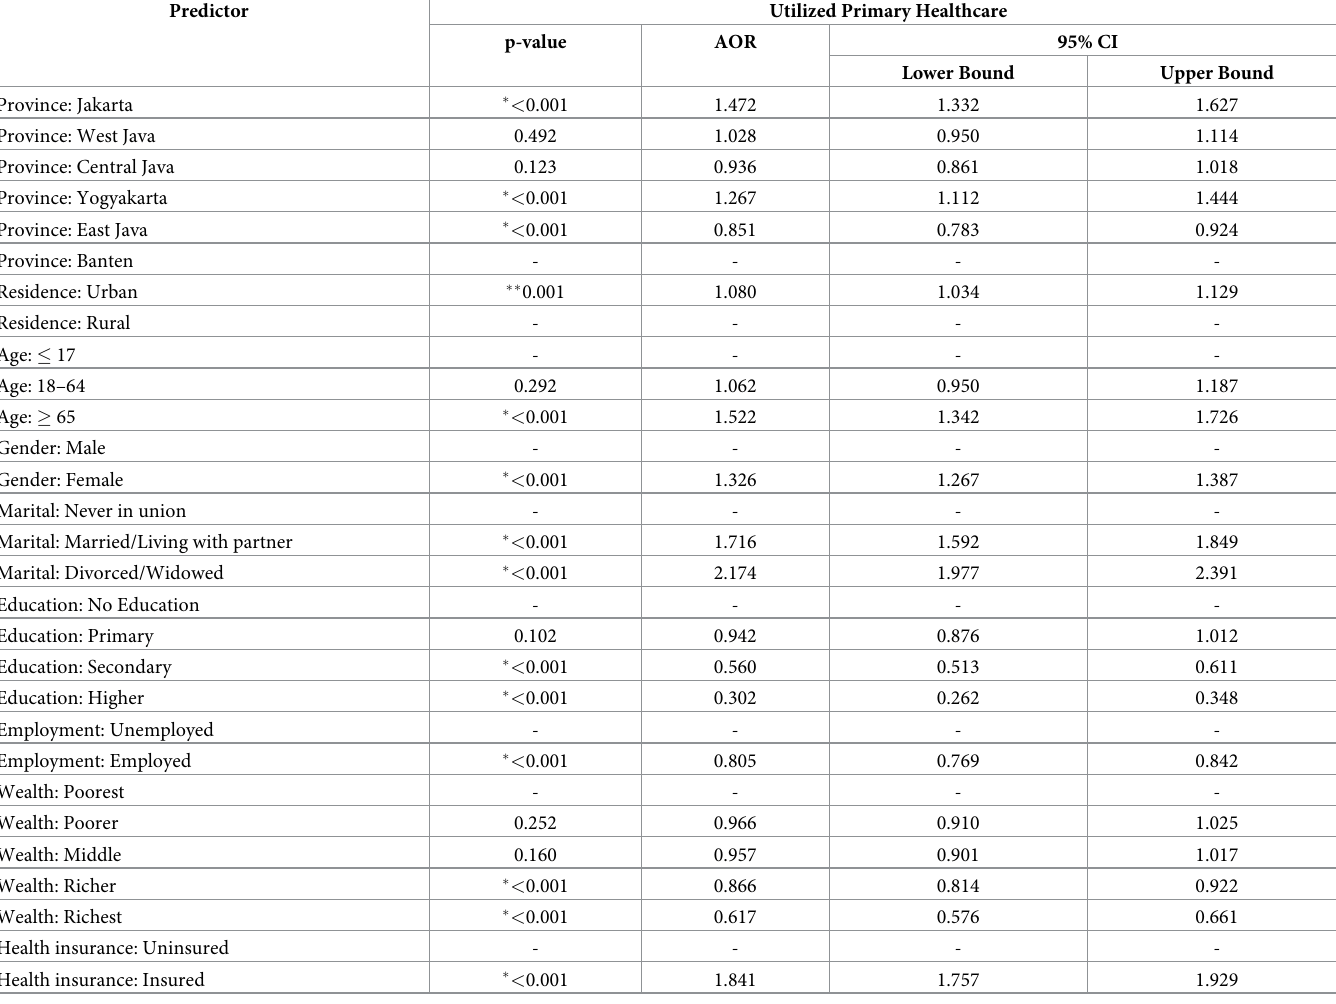
Table 2. The result of binary logistic regression of primary healthcare utilization in Java Region in Indonesia, 2018 (n = 213,140).